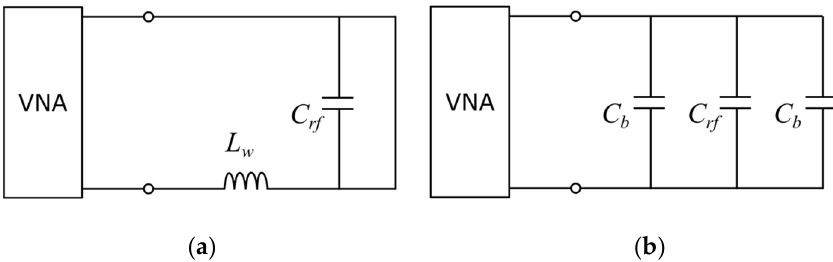
Figure 8. Equivalent parasitic circuit model for ( a ) zero speed and ( b ) rated speed conditions. The bearing is a short circuit at zero speed due to direct contact between the balls and races, while the bearing behaves as a capacitance at rated speed due to the balls riding on a film of lubricant.